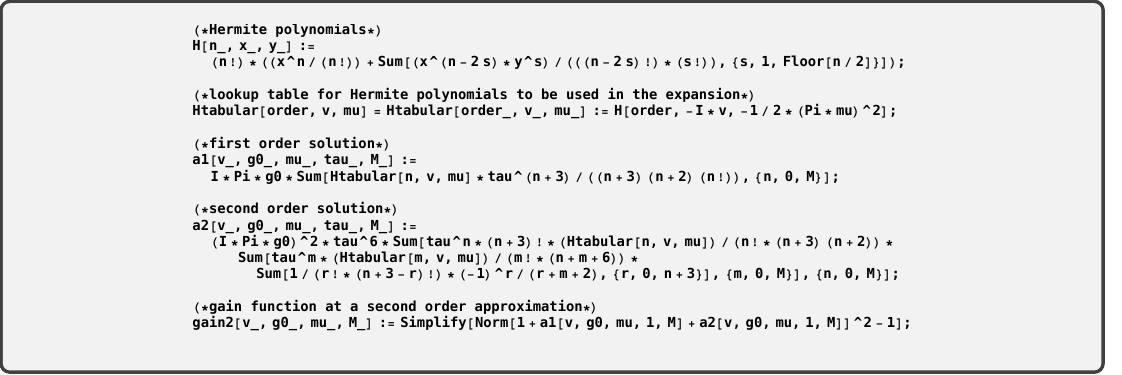
Figure A1. Working Mathematica